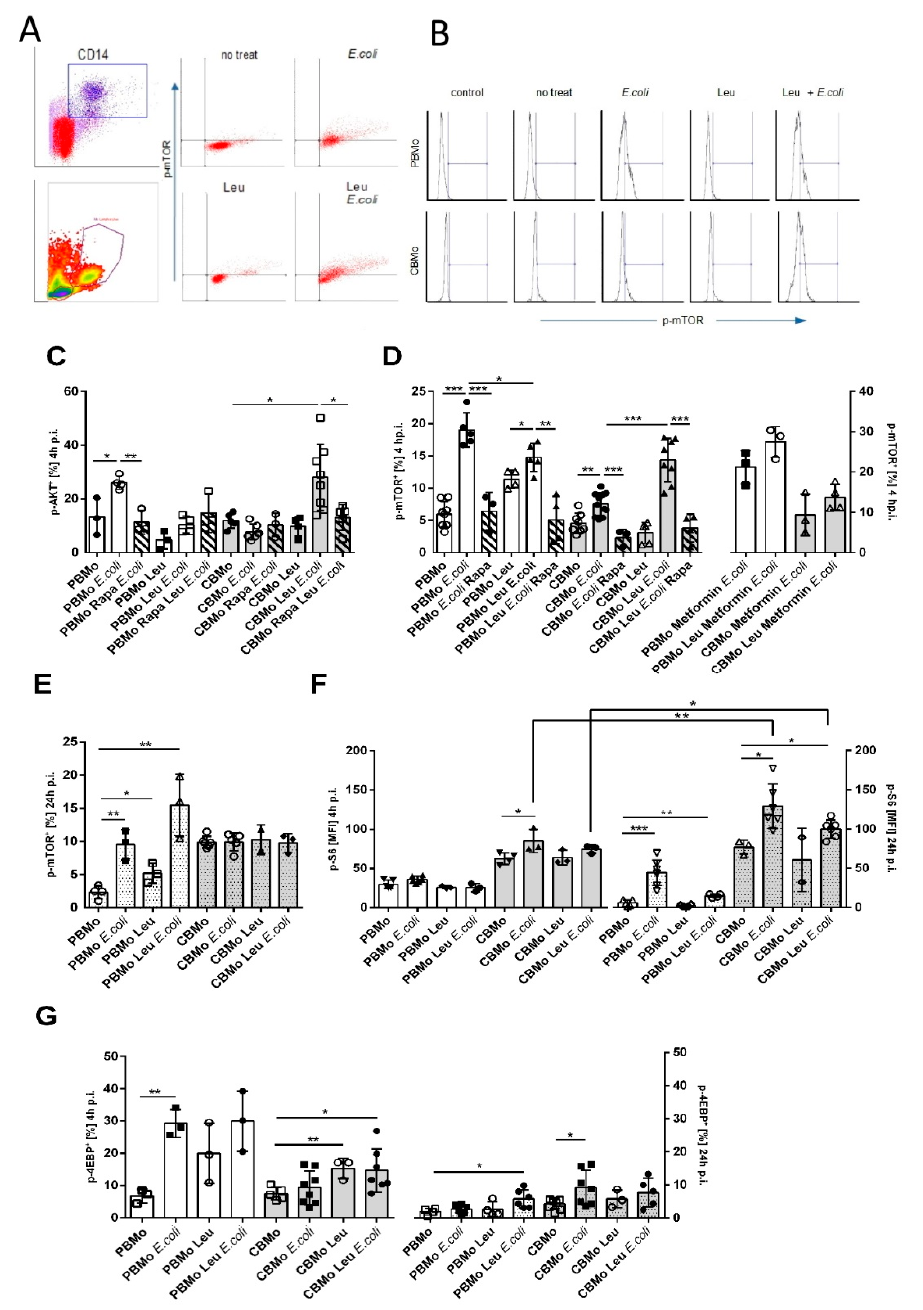
Figure 3. Leucine interferes with AKT/mTOR signaling. Gating strategy is depicted in ( A ). CD14-positive cells (dot plot) were back-gated to confirm Mo characteristics via position (density plot). Dot plots to the right show PBMo exhibiting phosphorylated mTOR. Histogram analysis ( B ) of the FACS-based p-mTOR staining for PBMo and CBMo under indicated conditions. The percentage of Mo exhibiting phosphorylated AKT was determined ( C ). The percentage of Mo expressing the phosphorylated form of mTOR was assessed ( D ). Indicated groups received leucine and metformin, respectively. Hatched columns indicate groups which received rapamycin (Rapa). Please note the different y-axis scale in the left and right panel of ( D ). ( E ) shows phosphorylated mTOR for a 24 h p.i. infection interval and ( F ) the phosphorylation of mTOR substrate S6 ribosomal protein in infection intervals of 4 h.p.i. (blank columns) and 24 h p.i. (dotted columns). The percentage of Mo exhibiting the phosphorylated mTOR substrate 4EBP is given in ( G ) for the indicated infection interval (all charts give error bars representing the standard deviation (SD); Student’s t -test * p < 0.05; ** p < 0.01, *** p <